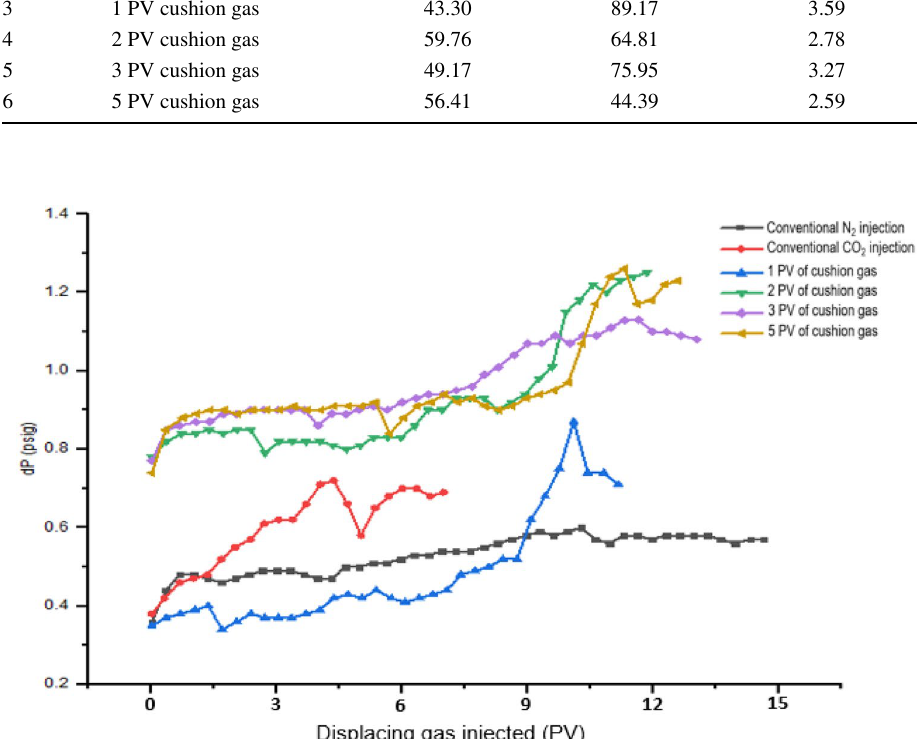
Table 5 Efficiency of core flooding process in terms of CH 4 recovery and CO 2 sequestration for all runs